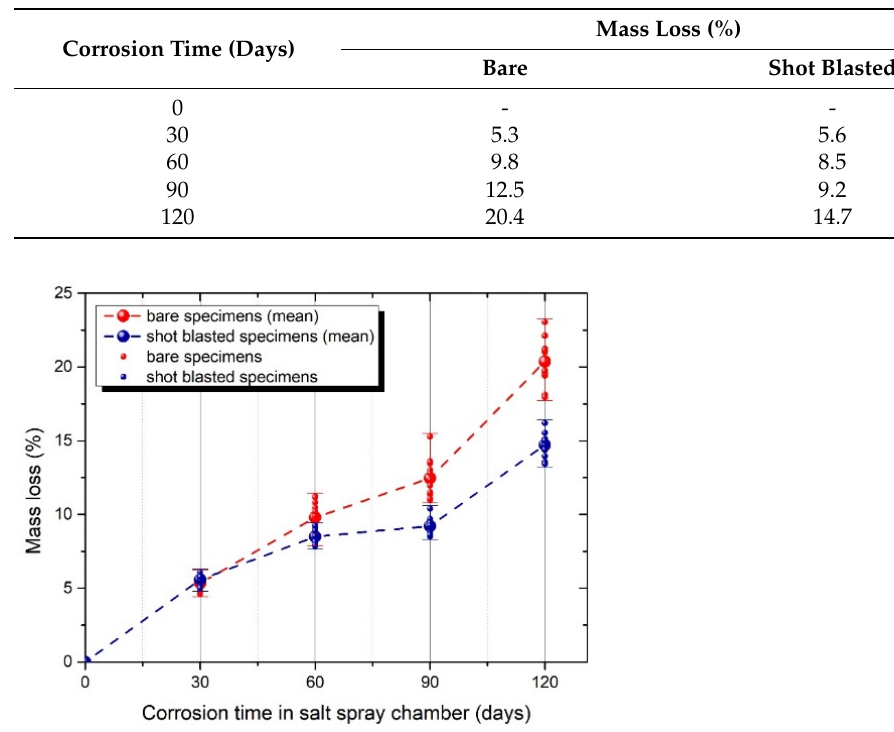
Table 6. Percentage mass loss toward corrosion time for fatigue specimens.